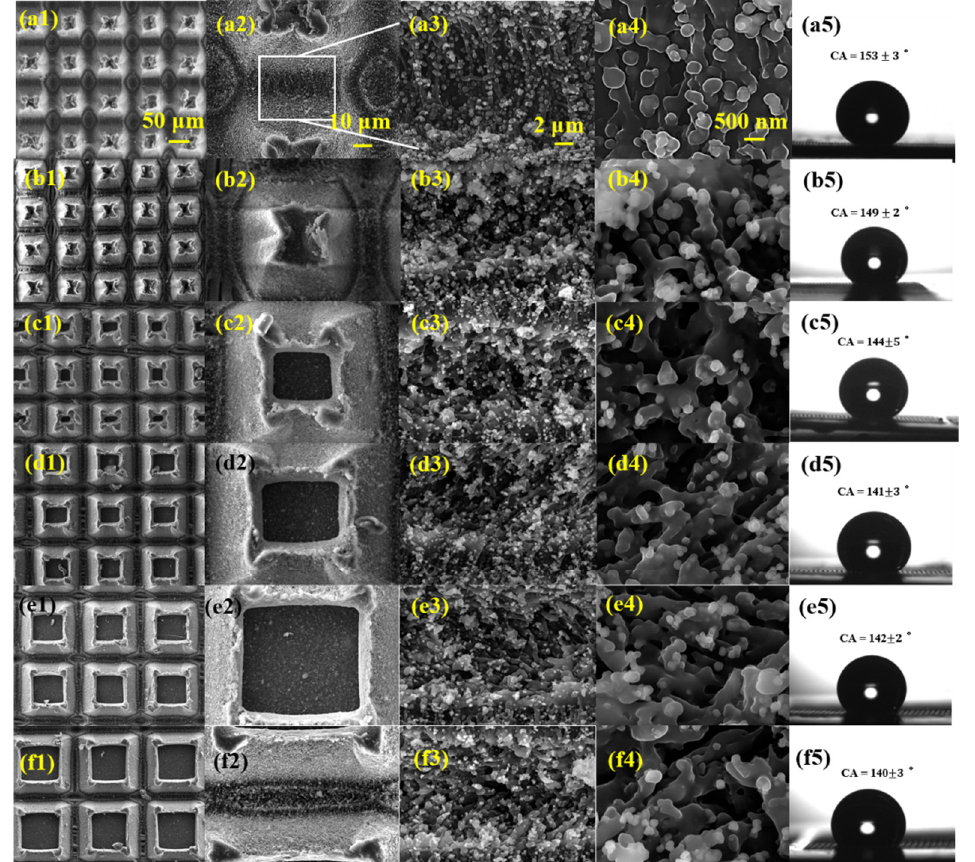
Figure 3. SEM images of grid structure with different spaces and the corresponding contact angle images. ( a1 – a5 ) Shows 80 µ m space, CA = 153 ± 3 ◦ , ( b1 – b5 ) 100 µ m space, CA = 149 ± 2 ◦ , ( c1 – c5 ) 120 µ m space, CA = 144 ± 5 ◦ , ( d1 – d5 ) 140 µ m space, CA = 141 ± 3 ◦ , ( e1 – e5 ) 160 µ m space, CA = 142 ± 2 ◦ , ( f1 – f5 ) 180 µ m space, CA = 140 ± 3 ◦ . The laser power density is 5.7 × 10 4 W/cm 2